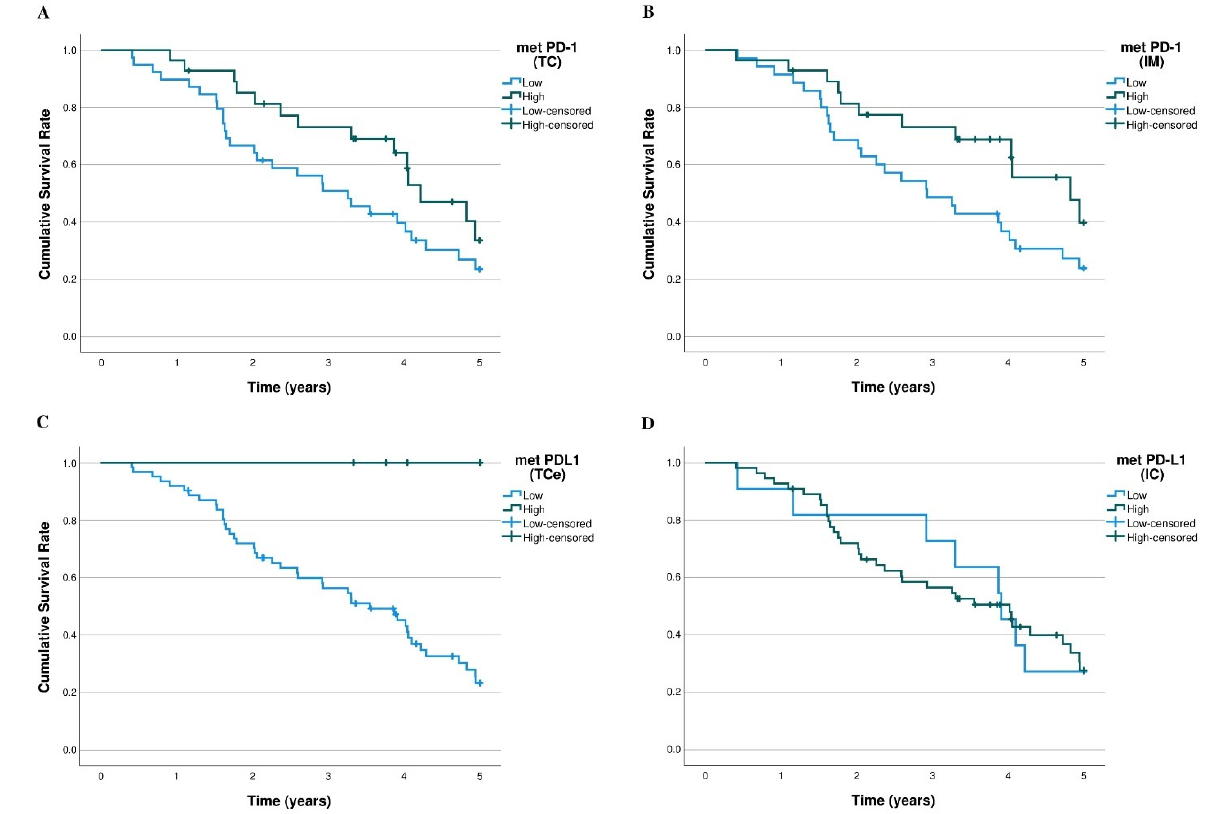
Figure 4. K-M 5-year overall survival curves of PD-1/PD-L1 expression in pulmonary metastases. ( A ) PD-1 expression ( n = 67) in the tumour centre ( p = 0.114). ( B ) PD-1 expression ( n = 63) in the invasive margin ( p = 0.066). ( C ) PD-L1 expression ( n = 67) in the tumour cells ( p = 0.024). ( D ) PD-L1 expression ( n = 66) in the tumour infiltrating immune cells ( p = 0.943).